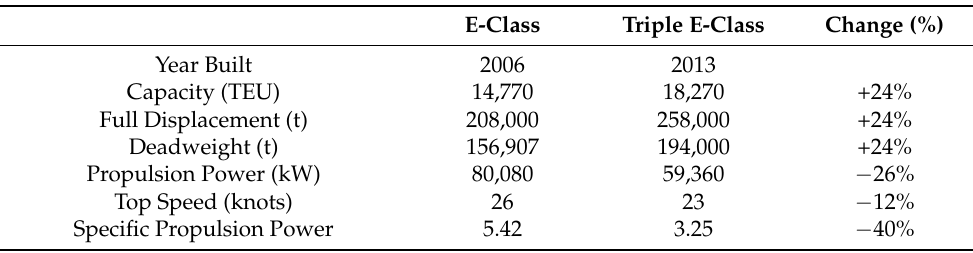
Table 1. Effect of reduced design speed on ship efficiency, − 7% due to economy of scale, − 33% due to speed, adapted from [34].